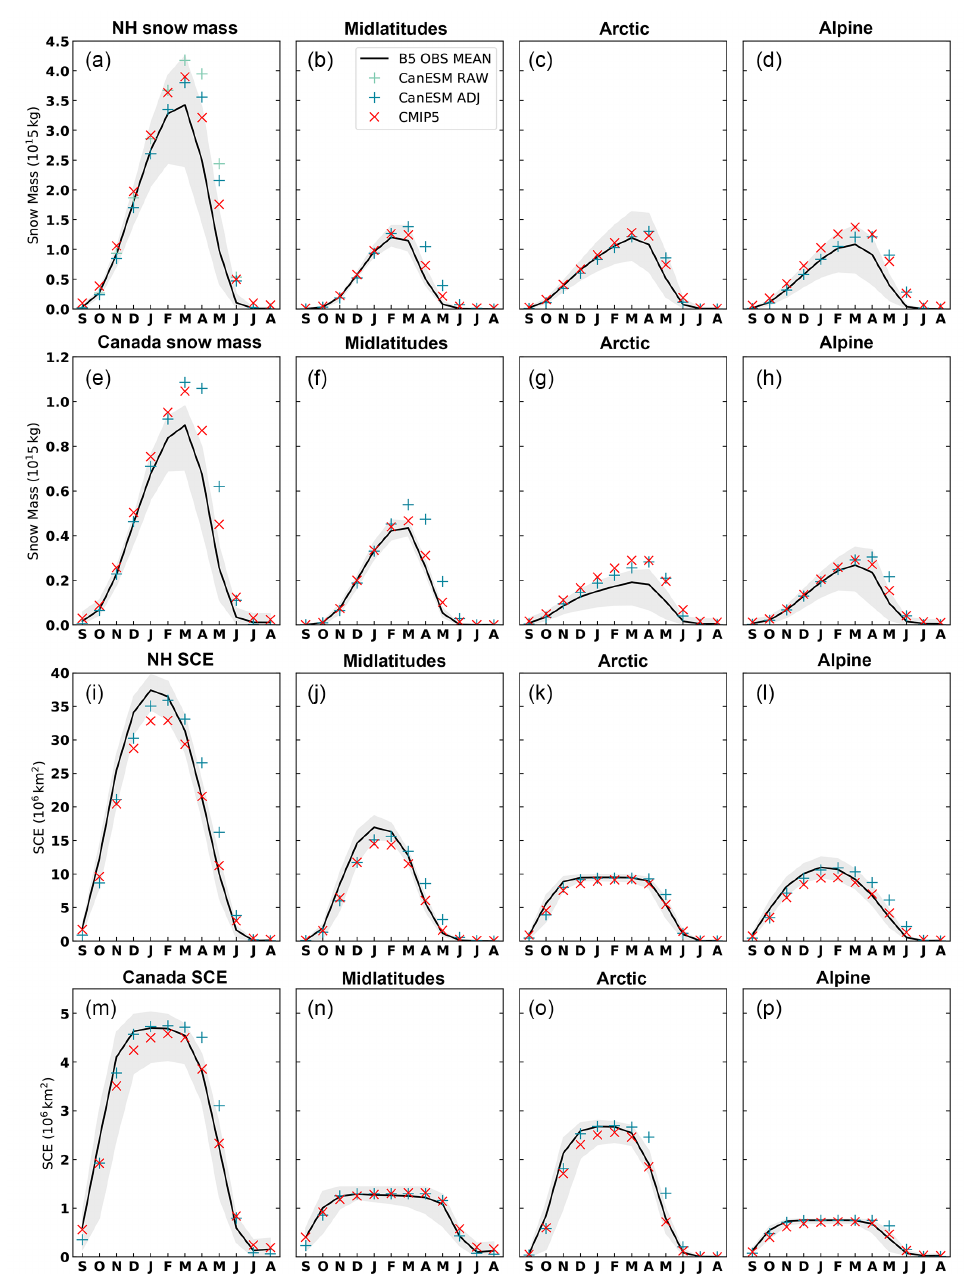
Figure 3. First row: seasonal cycle of Northern Hemisphere 1981–2005 snow mass (in 10 15 kg) for regions defined in Mudryk et al. (2015): midlatitudes, i.e. northern hemispheric non-alpine land regions south of 60 ◦ N; Arctic, i.e. non-alpine land regions north of 60 ◦ N; and alpine. Grey shading represents the range of Blended-5 datasets, the black curve represents the Blended-5 mean, the light teal points (in panel a ) mark the ensemble mean of CanESM2 using its land mask, and the dark teal points mark CanESM2 adjusted to represent the same land fractions as the observational mask from the Blended-5 dataset. The CMIP multi-model mean, adjusted to the observational mask, is show with red x symbols. The legend in panel (b) applies to the figure as a whole. Panels e–h as in panels a–d , but for Canadian land mass only. Panels (i–l) and (m–p) are similar to (a–d) and (e–h) , but for snow cover extent in 10 6 km 2 . The estimate of observed snow cover extent is derived from the Blended-5 SWE dataset using the approach of Mudryk et al. (2017) and is based on a 4mm SWE threshold for the presence of snow cover; the simulated snow cover extent is based on snow cover fraction directly produced by the